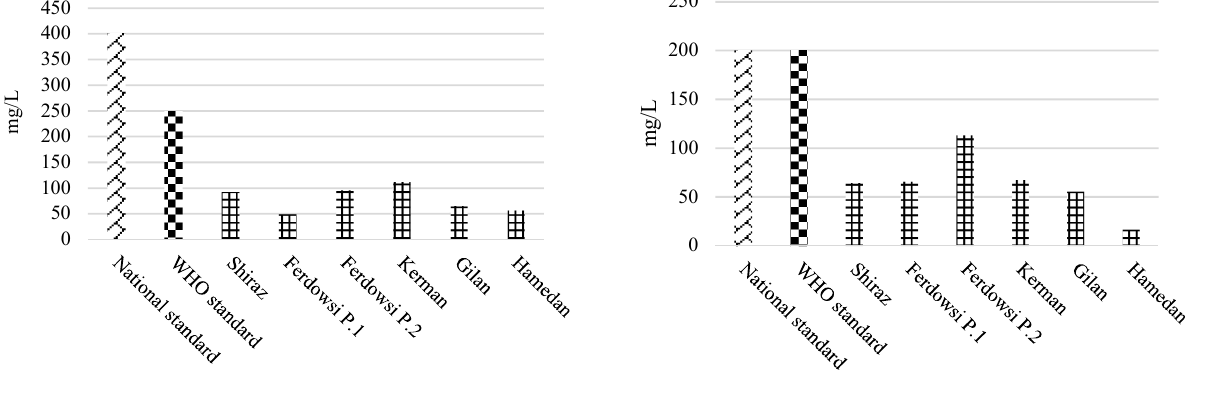
Fig. 2. Comparison of the amount of chlorine to the national and global standard